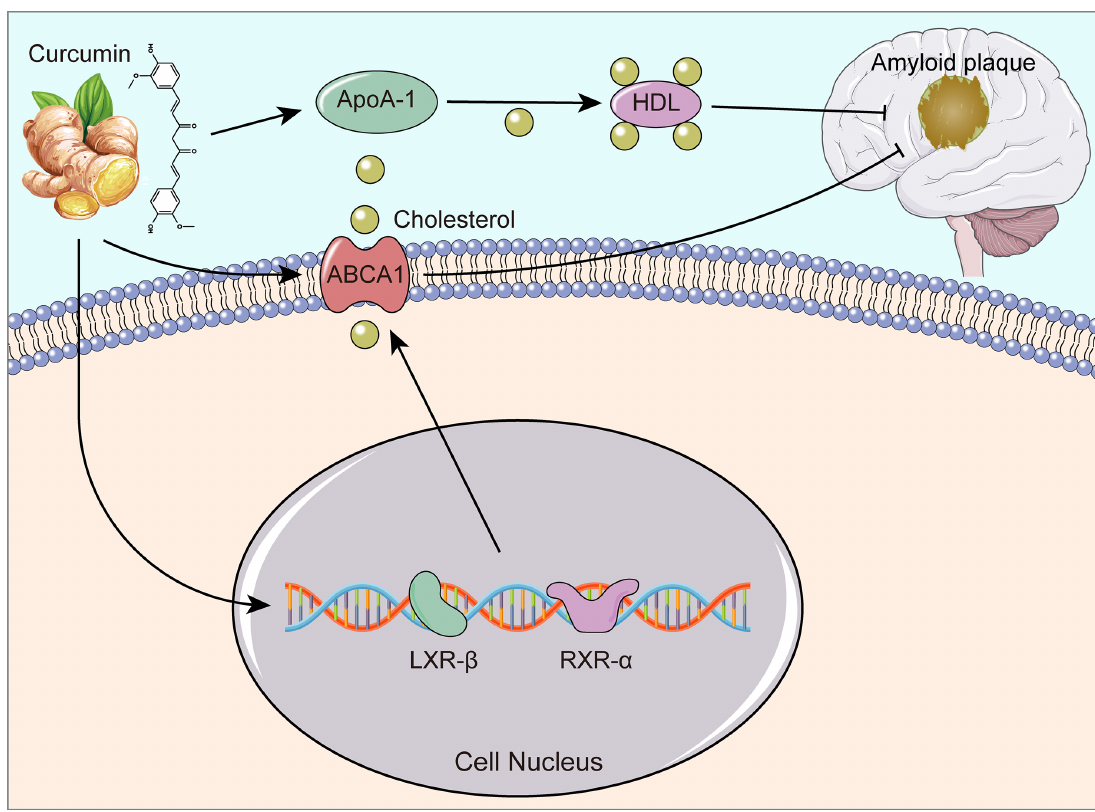
Fig.6. Schematicdiagramaboutthecurcumin’spossiblemechanisms. Curcumin could promote the expression of LXR- β and RXR- α , which activated the ABCA1 cholesterol transmembrane system, thus maintaining the metabolic balance between intracellular and extracellular cholesterol. At the same time, curcumin reduces the serum total cholesterol level by increasing HDL levels and its source protein apoA1. In addition, the effect of curcumin on inhibiting the deposition of A β in the brain of mice may be achieved through the pathways mentioned above. Therefore, curcumin can improve lipid metabolic disorder and cognitive dysfunction by promoting the ABCA1 transmembrane transport